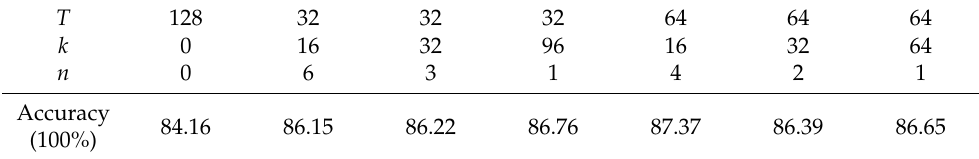
Table 3. Comparison of model level identification accuracy with varying parameter settings.